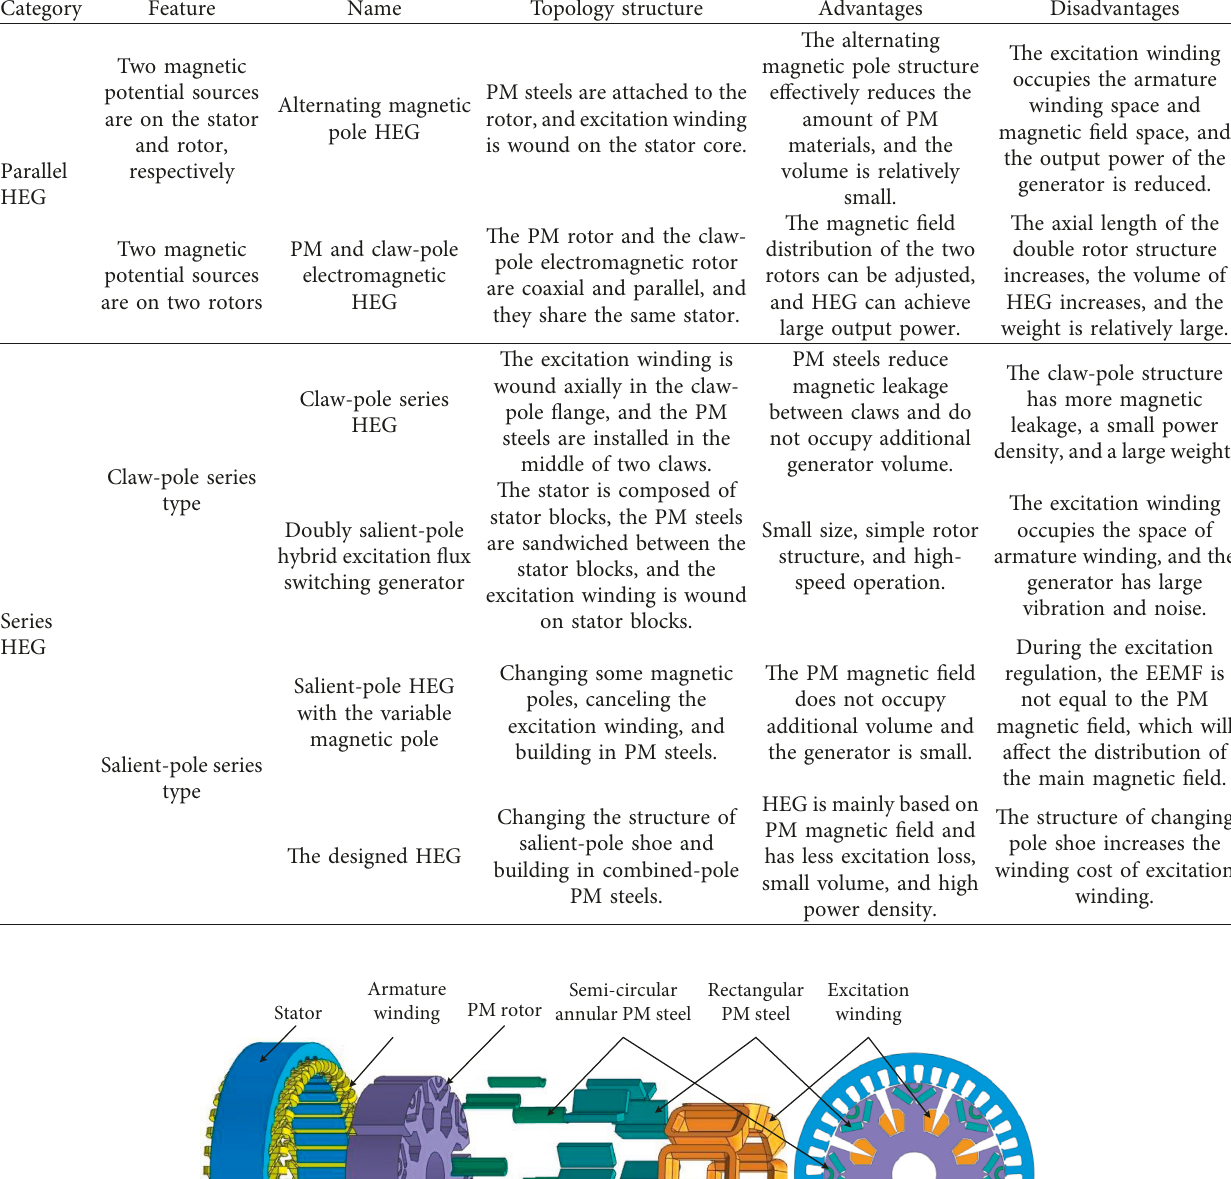
Table 1: Comparison of topology structure and performance of HEG.